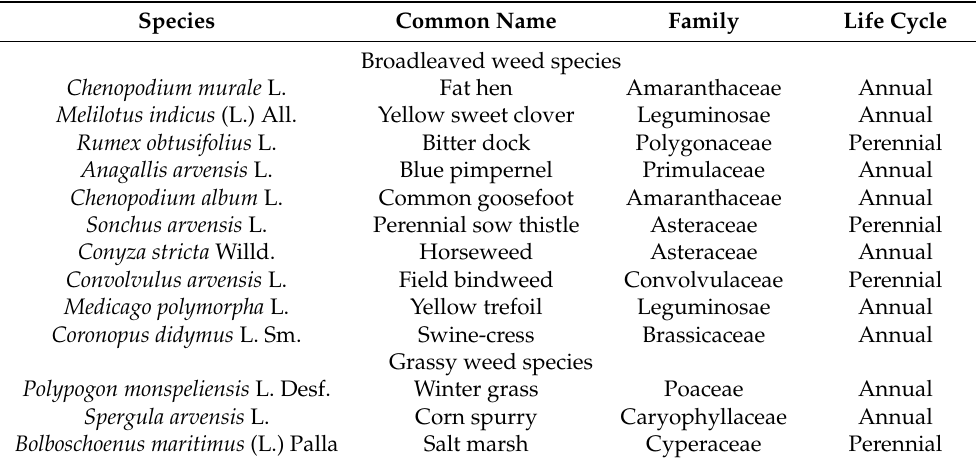
Table 1. Common and Latin names, family, and life cycle of different weed species recorded in barley crop during both years of the study. Species Common Name Family Life Cycle Broadleaved weed species Chenopodium murale L. Fat hen Melilotus indicus (L.) All. Rumex obtusifolius